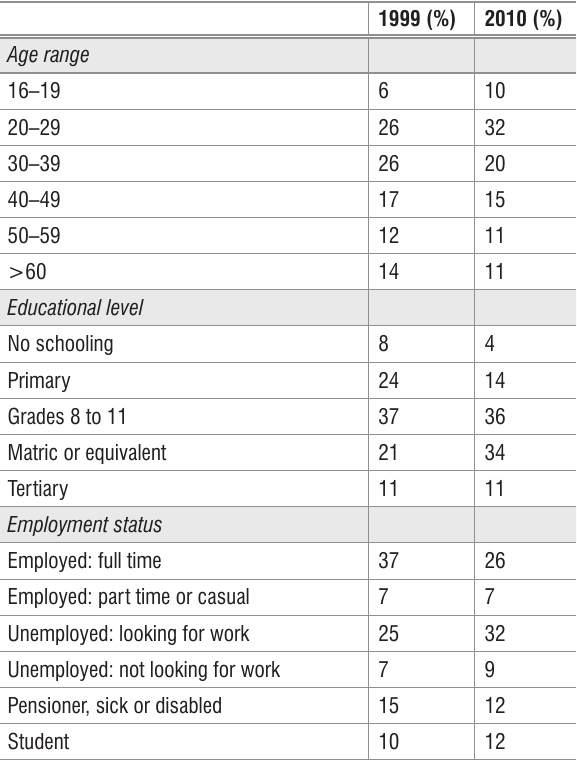
Age profile, educational level and employment status of the South African Social Attitudes Survey